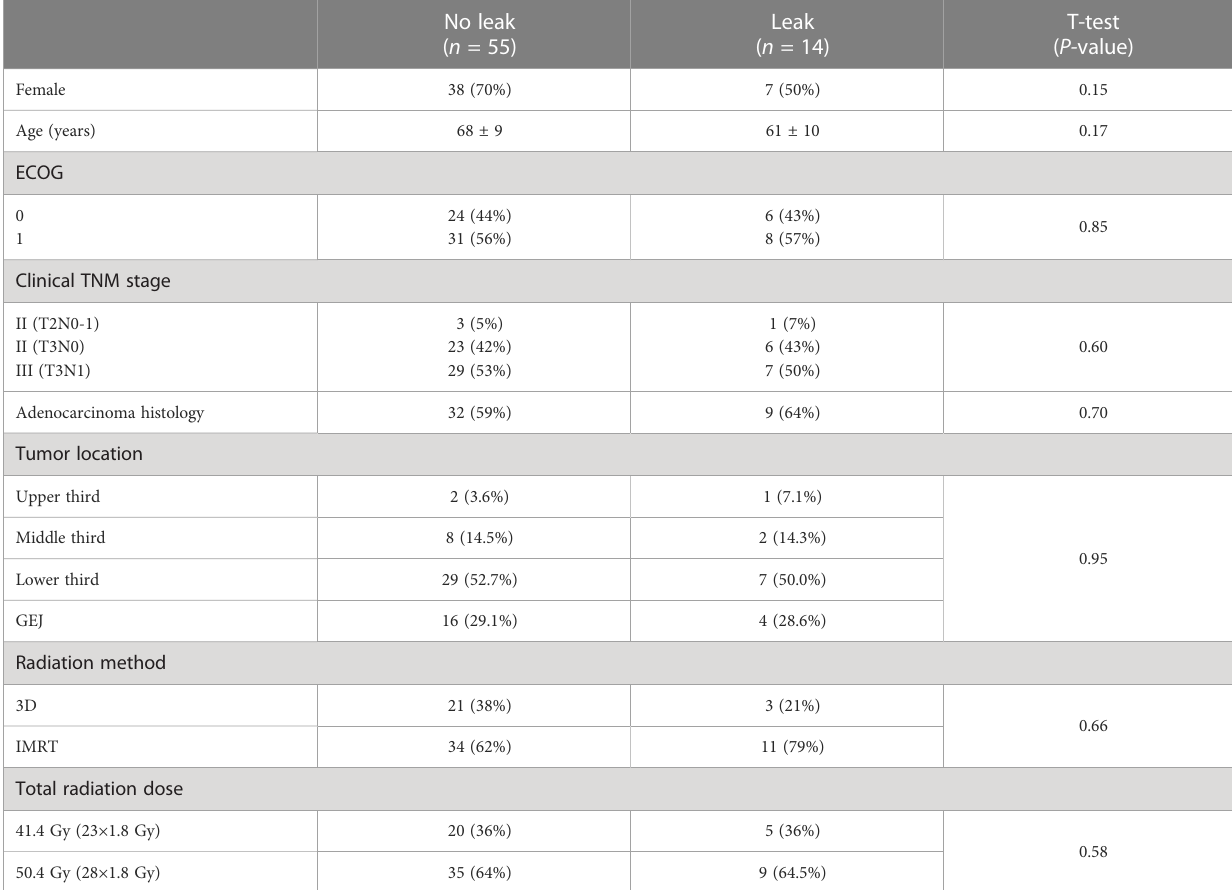
TABLE 1 Baseline patient